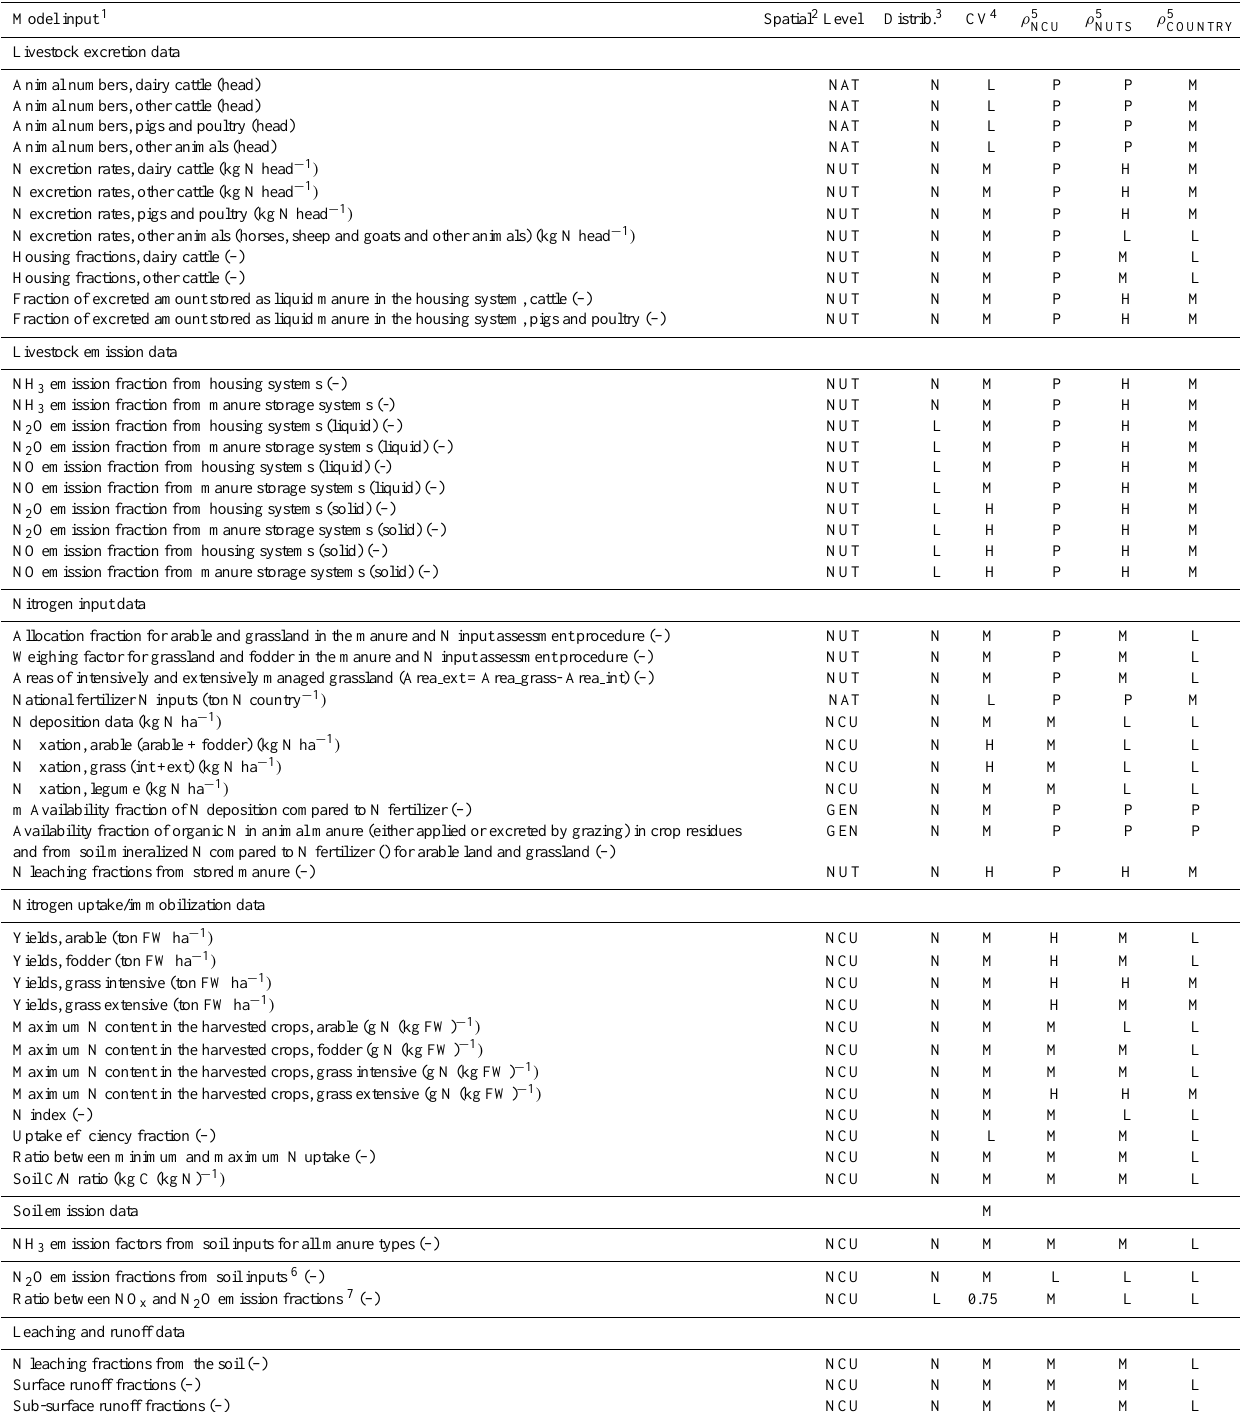
Table 4. Statistical properties and spatial levels of uncertain model